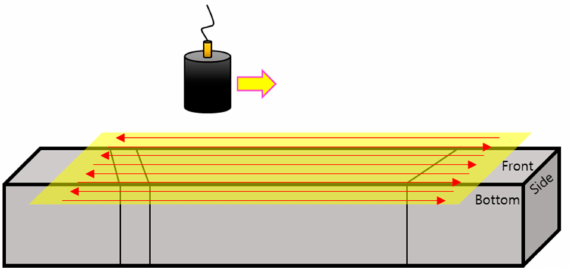
Figure 11. Experimental setup for scanning the dissimilar-metal-welded specimen using the pulse-echo